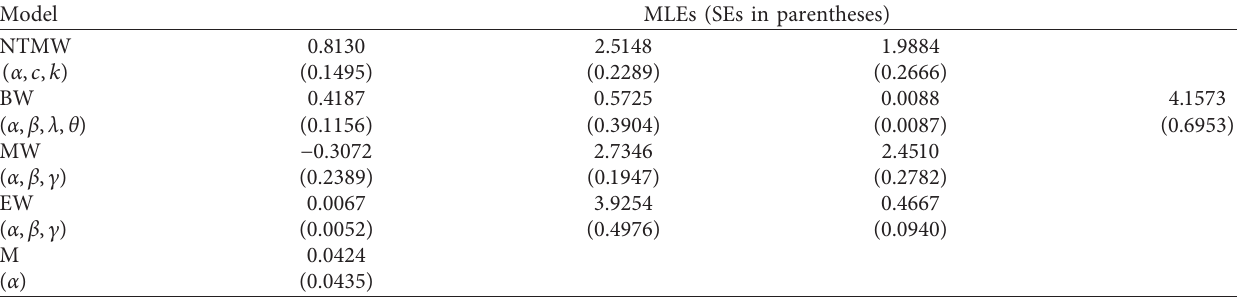
Table 10: Values of the estimates for dataset II.